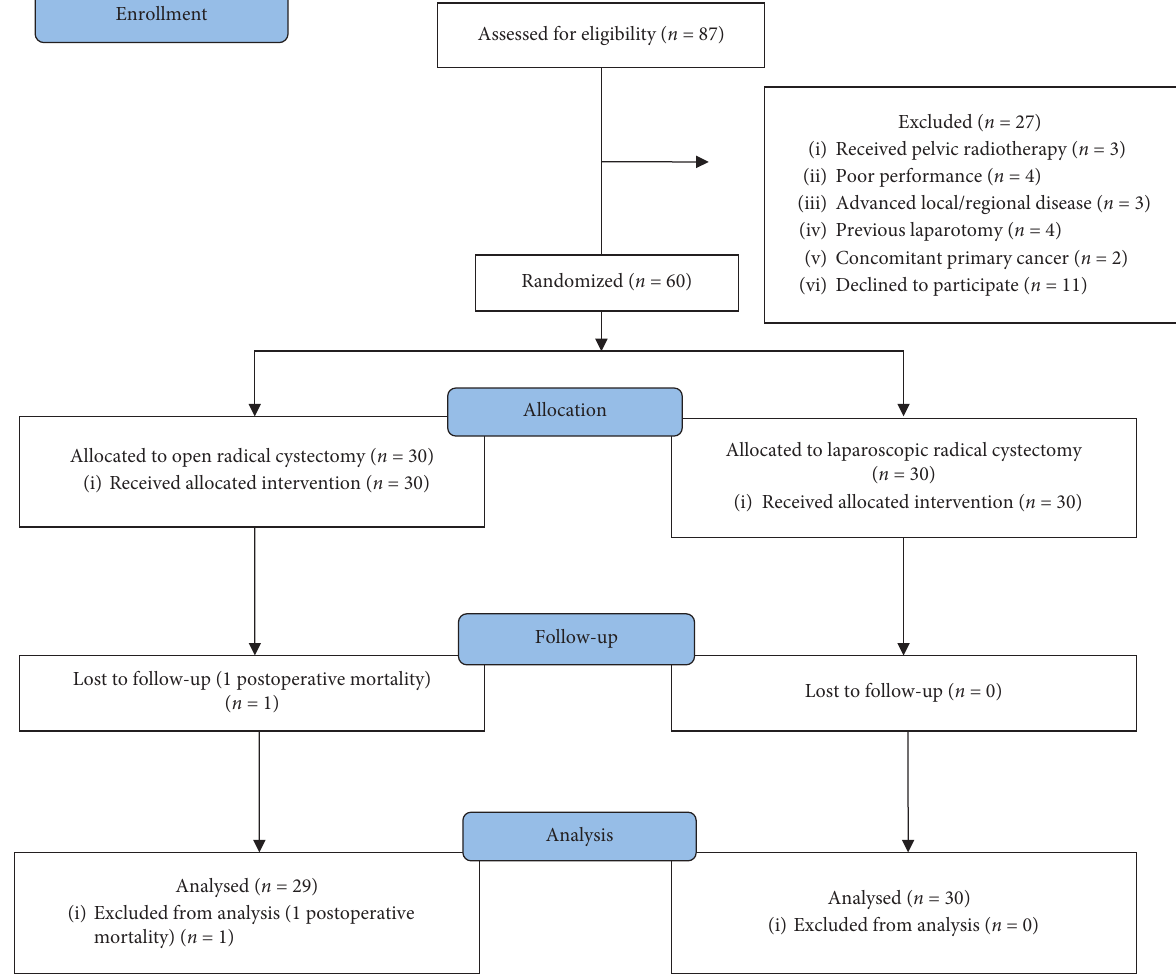
Figure 1: Flowchart of the